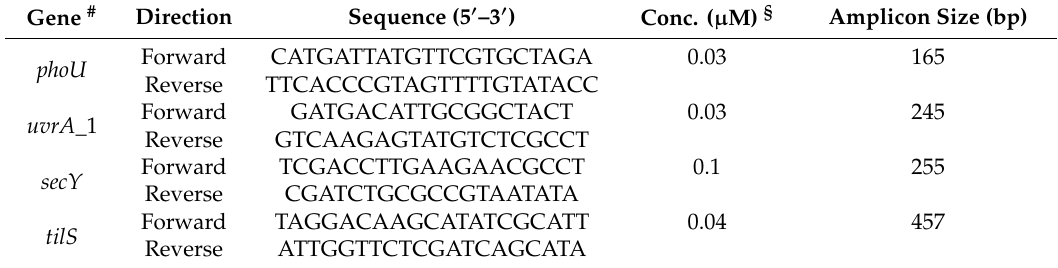
Table 1. Multiplex PCR primers designed to direct strain typing for Lactobacillus acidophilus LA1063.